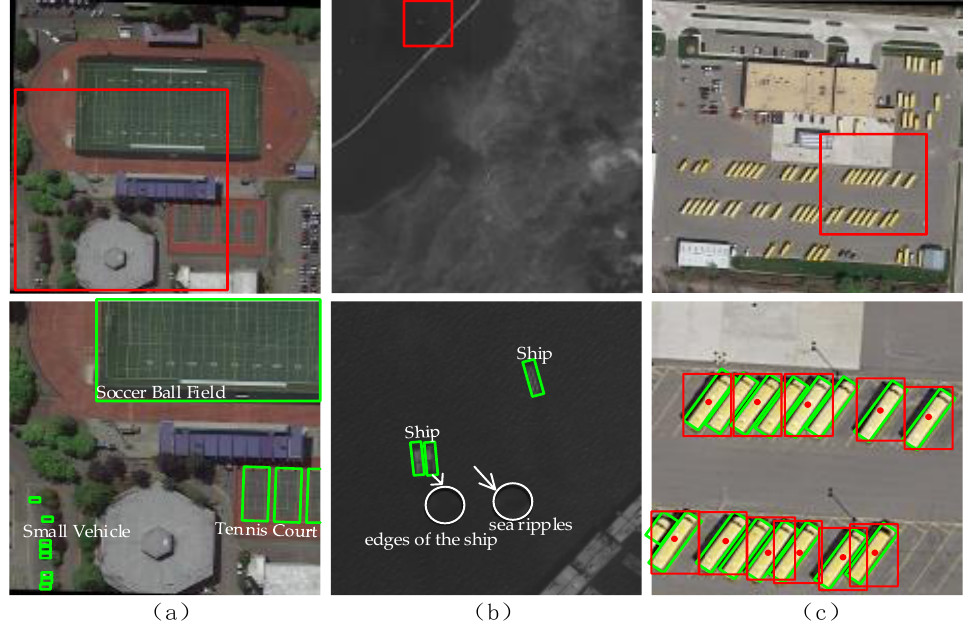
Figure 1. Characteristics of remote sensing images. The images on the second row represent the enlarged drawings of the corresponding red boxes in the first row. ( a ) Objects vary greatly in scale. ( b ) Small objects are easily submerged by background noises. ( c ) Objects appear in various orientations and are densely arranged.